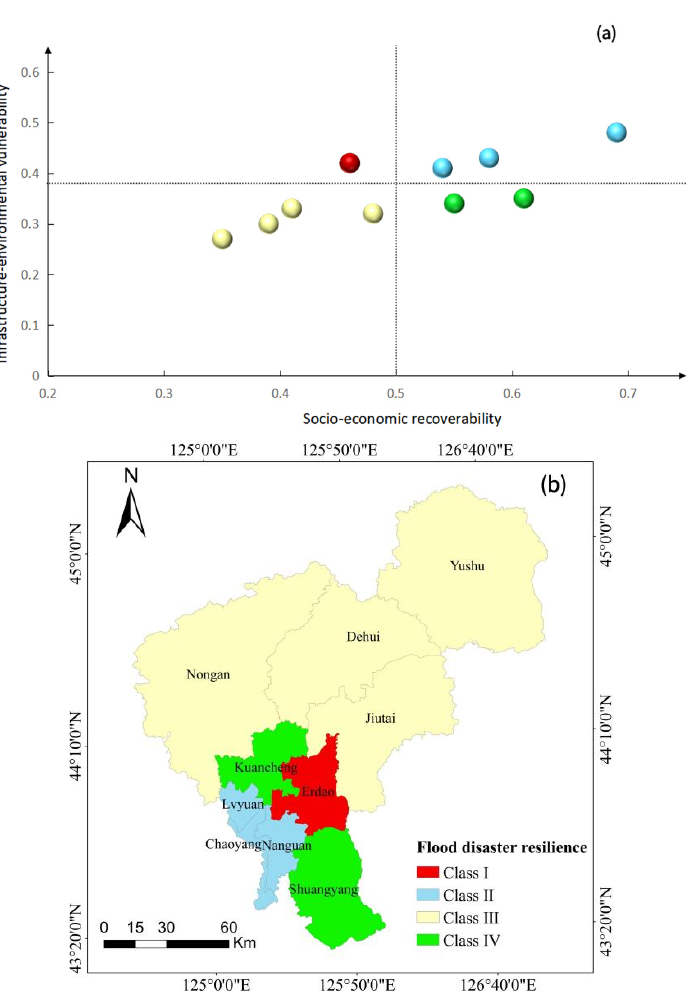
Figure 6. Changchun fl ood resilience cluster: cluster classi fi cation ( a ); spatial distribution of clusters ( b ).